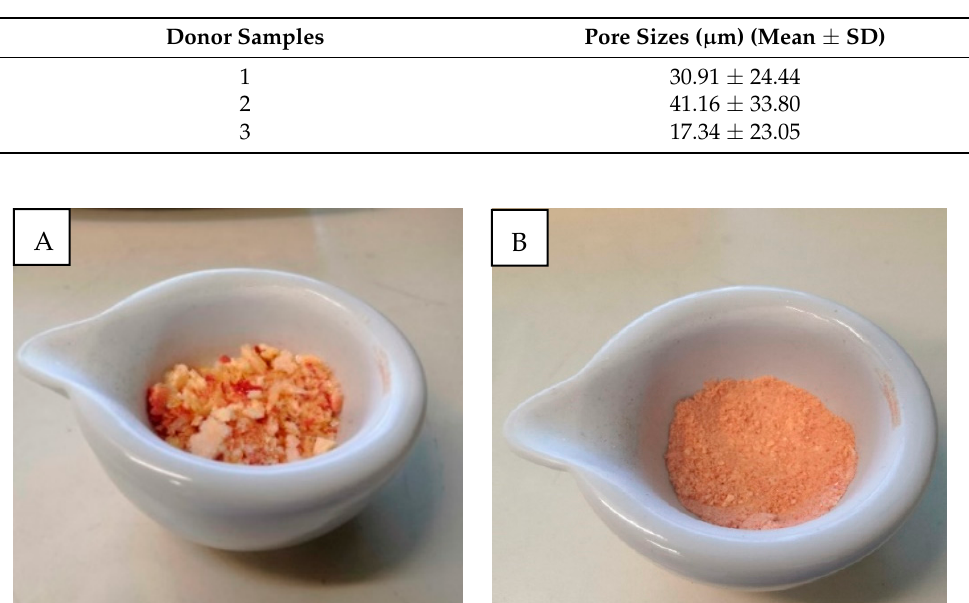
Figure 1. Platelet-rich fibrin (PRF) preparation. ( A ) Venous blood centrifuged for separation. PRF clot formed in the tube centre between red blood cells and platelet-poor plasma fractions. Appearance of ( B ) fresh PRF, ( C ) frozen PRF, and ( D ) lyophilised PRF. Table 2. Comparative Ly-PRF pore sizes.